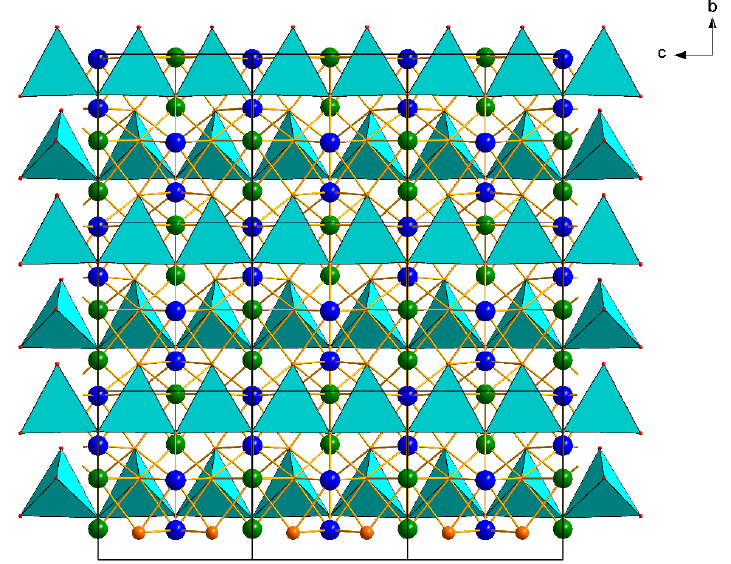
Figure 10. The crystal structure of cerromojonite projected down [100] (six unit-cells). Symbols as in